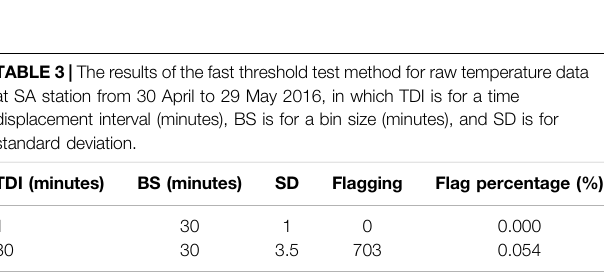
FIGURE 2 | The difference between the maximum/minimum threshold and the temperature at SA station from 30 April to 29 May 2016 (Unit: ° C), in which the maximum thresholds minus 0.5 Hz temperature (red line) and 0.5 Hz temperature minus the minimum thresholds (blue line). (A) Scheme 7; and (B) scheme 11.